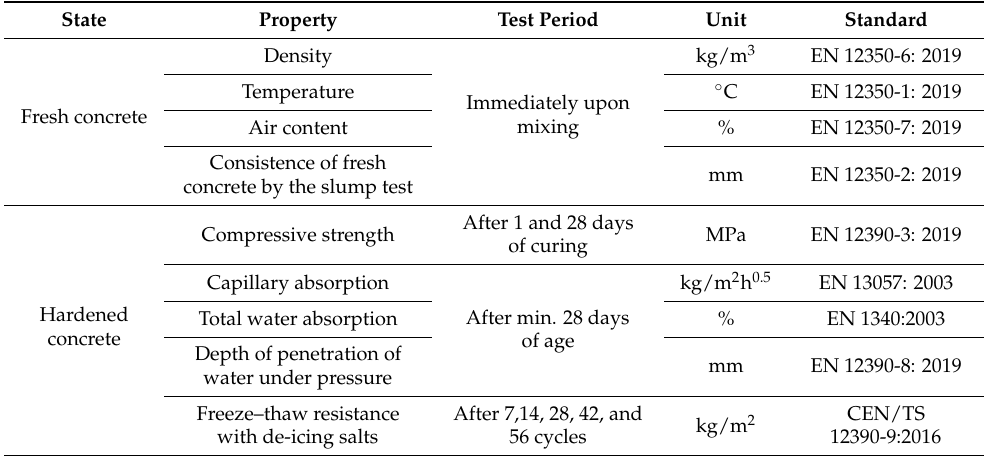
Table 4. Test methods for assessment of concrete in fresh and hardened